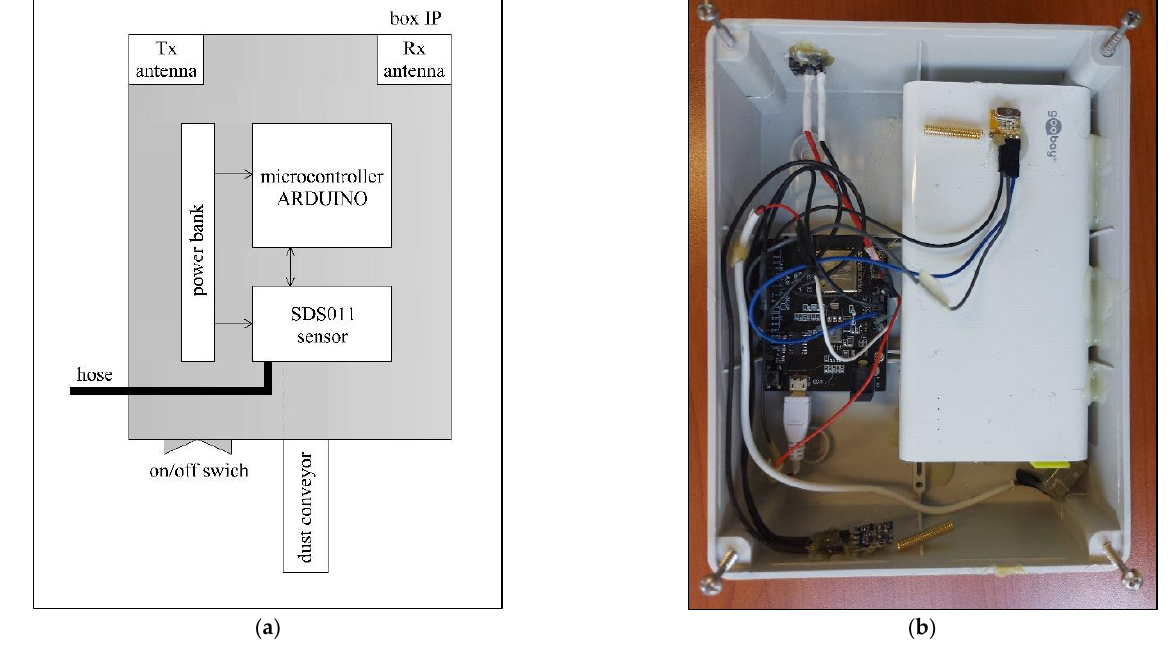
Figure 4. ( a ) Scheme of a single node, ( b ) photo of a single